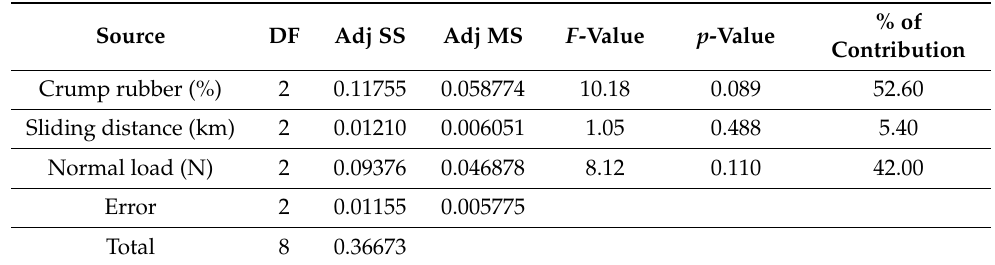
Table 9. ANOVA analysis for the specific wear rate .